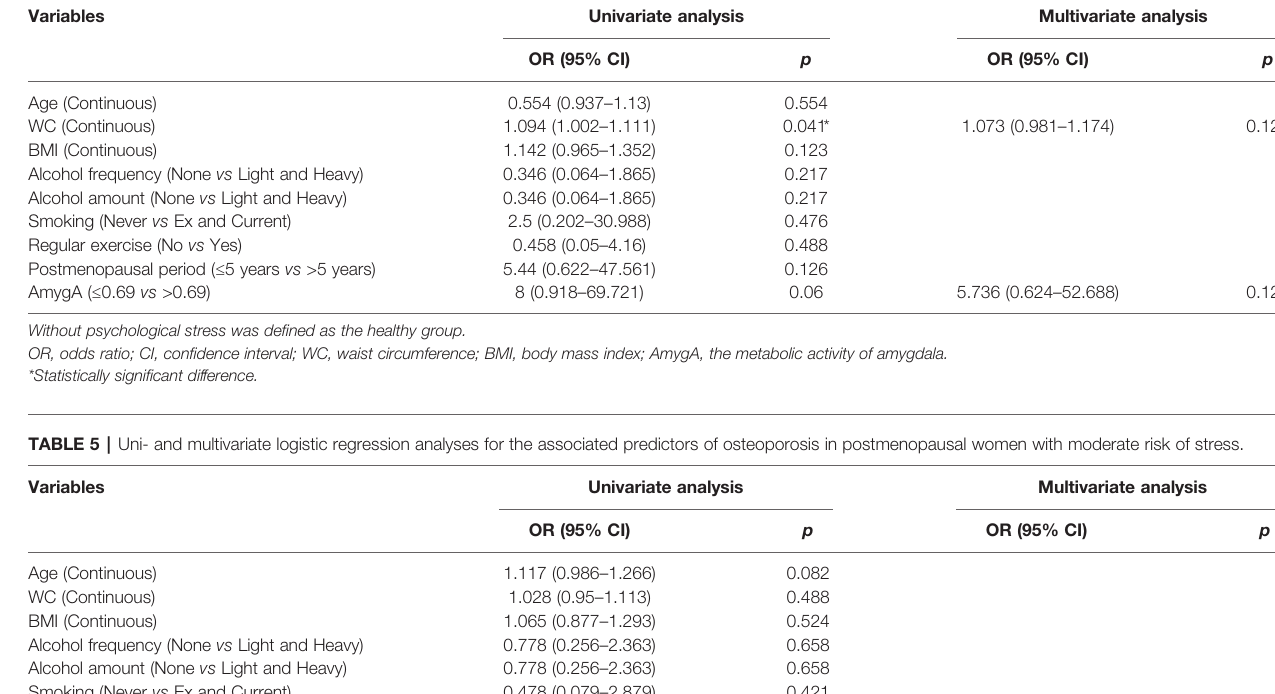
TABLE 4 | Uni- and multivariate logistic regression analyses for the associated predictors of osteoporosis in postmenopausal women without psychological stress. Variables Univariate analysis Multivariate analysis